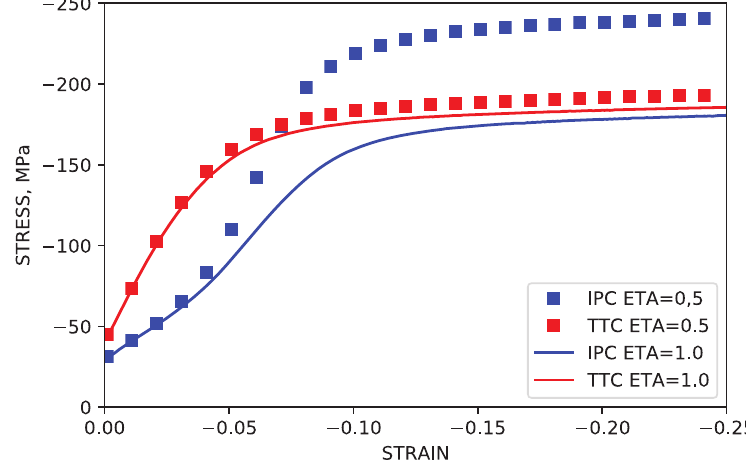
Figure 10. Simulated stress-strain curves with a dissociation parameter of η = 0.5 and dissociation parameter η = 1.0. These values correspond to a state of active dislocation transmutation and a state of no transmutation,